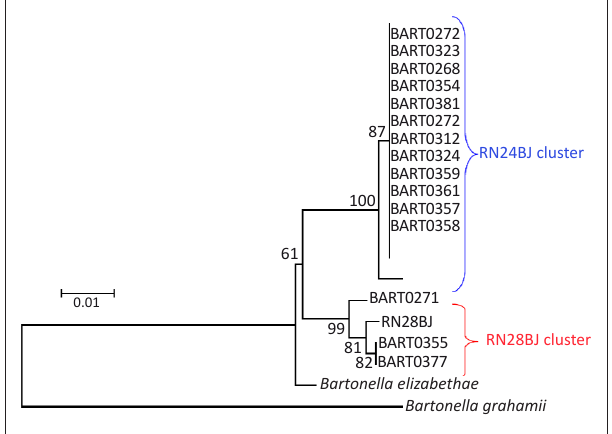
FIGURE 3: Tree of